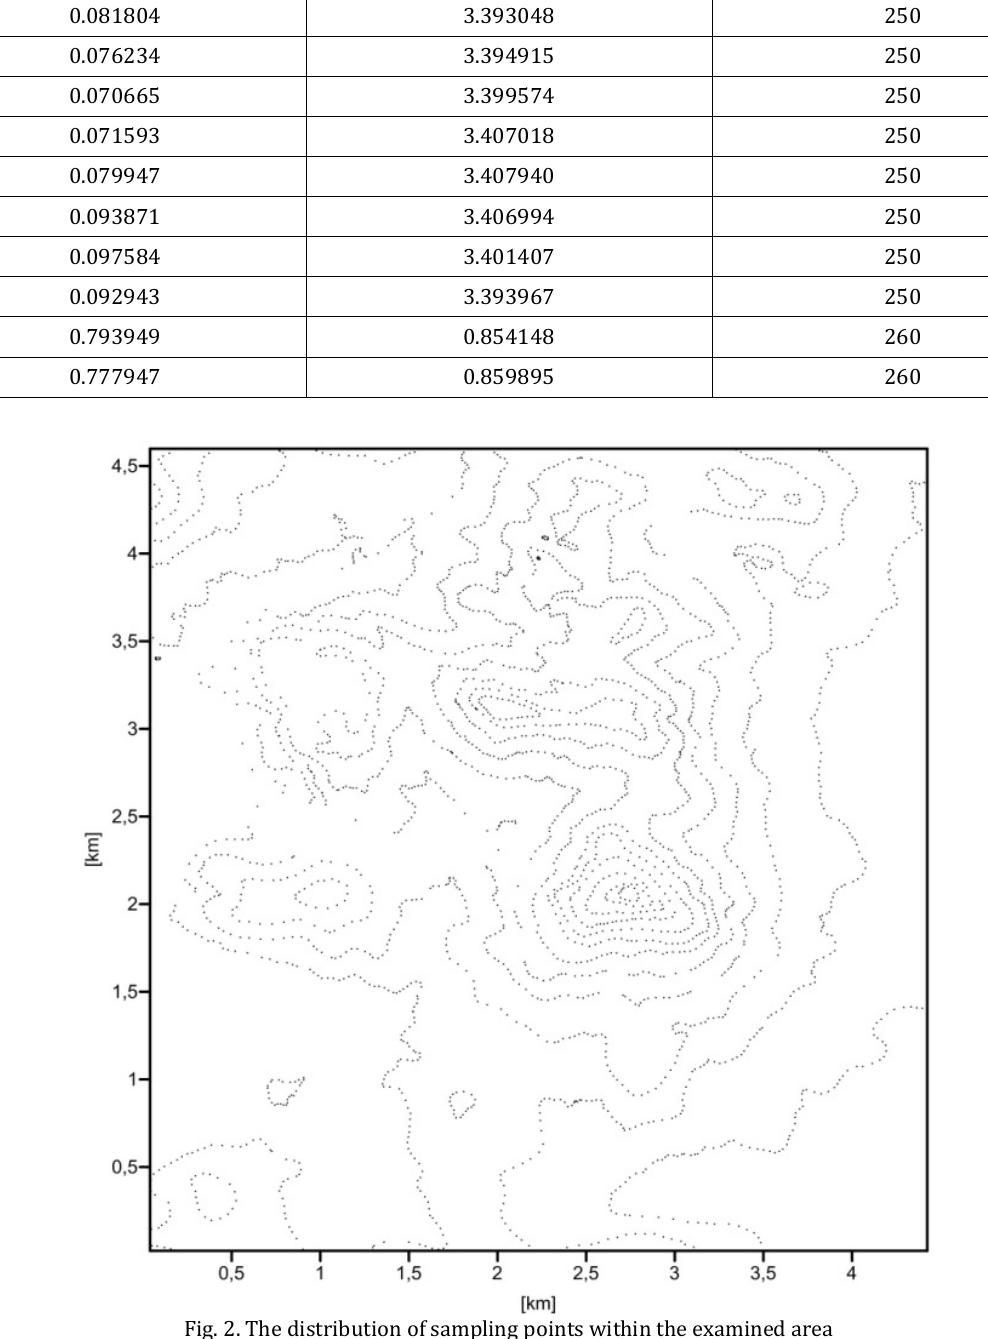
Table 1. Cartesian coordinates (XY) of 10 selected sampling points along with their height values (Z) within examined area